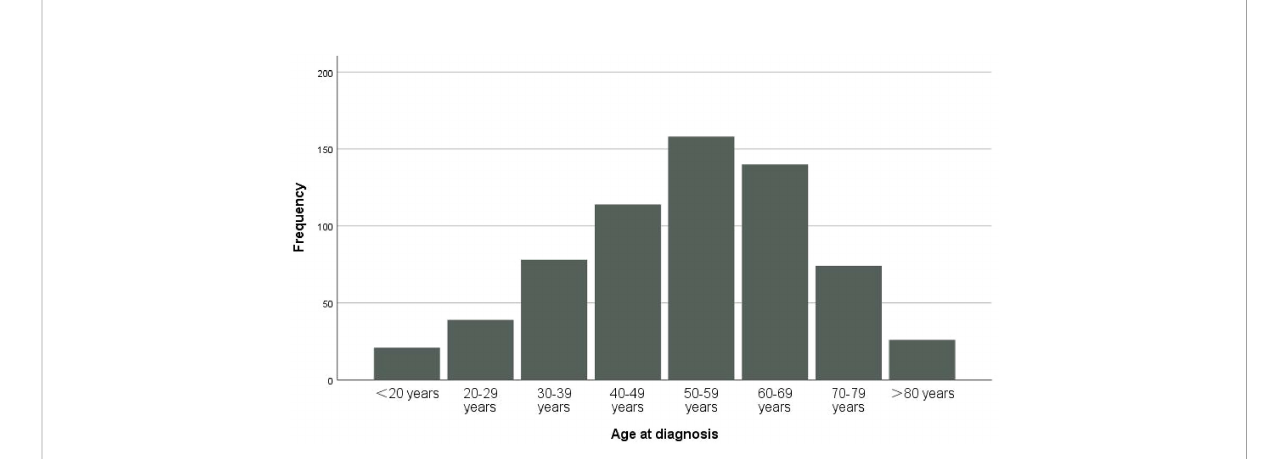
FIGURE 2 The distribution of the patients based on age at